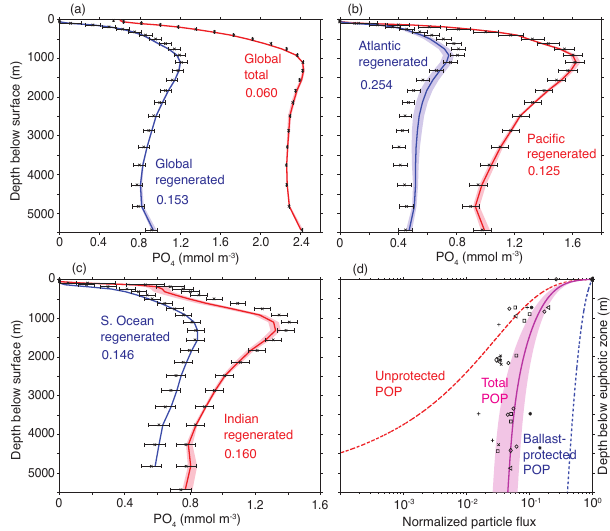
Figure 7. As Fig. 5, but for BUR+BAL model. In (d) , the average sinking fluxes of unprotected POP (dashed red curve) and ballast- protected POP (dashed blue curve) are shown separately. The un- certainty on the total POP sinking flux (magenta curve + shading) reflects uncertainty on the parameters c r and ζ of PRiSM, and spa- tial variability in the ratio of ballast mineral to organic carbon flux at the base of the euphotic zone (see Fig.